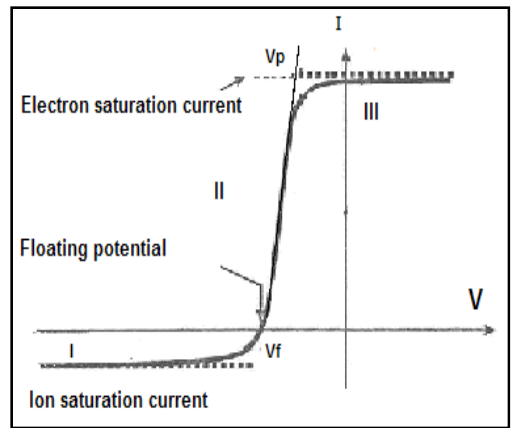
Fig.1: I-Vcharacteristics of singleLangmuir